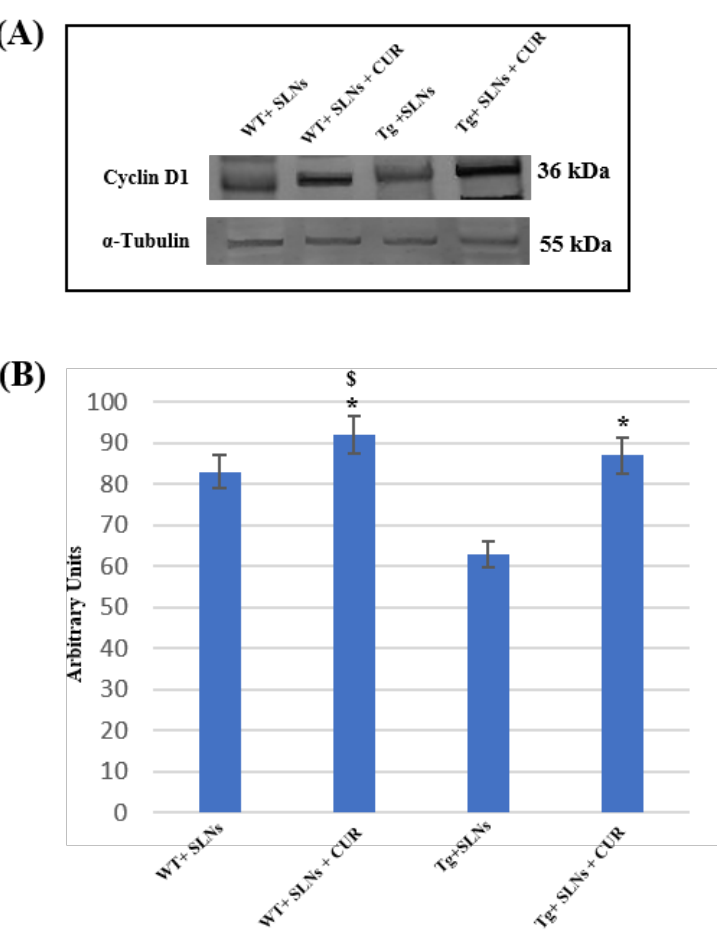
Figure 3. ( A ) Representative immunoblots through Western blotting analysis for Cyclin-D 1 expression levels in total cellular lysate from WT-SLNs, WT-SLNs-CUR, Tg-SLNs, and Tg-SLNs-CUR mice systemically administrated for 3 weeks. ( B ) Densitometric analysis of Cyclin-D 1 expression levels performed after normalization with α -tubulin. The results are expressed as the mean ± S.D. of the values of five separate experiments performed in triplicate. * p < 0.05, Tg-SLNs-CUR vs. Tg-SLNs; $ p < 0.05.